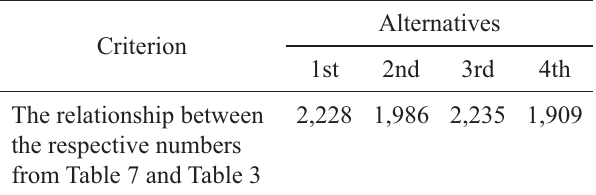
Table 7. Comparison of the results obtained in multicriteria evaluation of the considered object’s alternatives, depending on the normalization method used Alternatives Criterion 2nd 3rd 4th The relationship between the respective numbers from Table 7 and Table